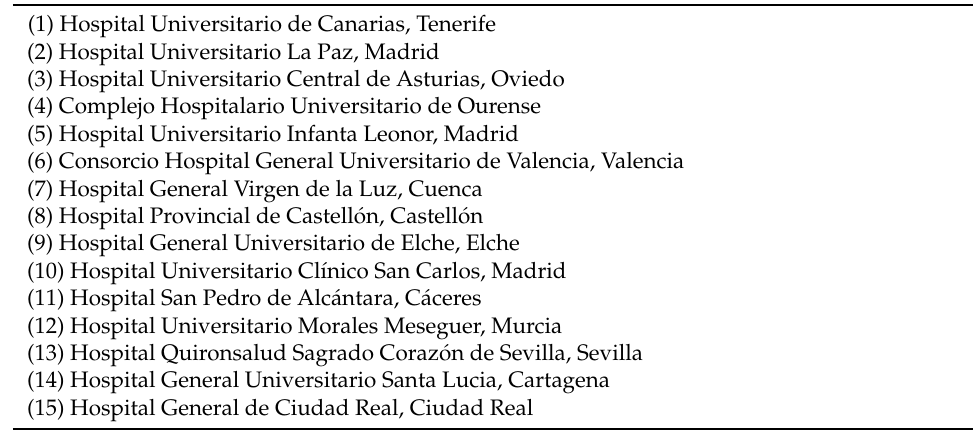
Table A1. List of 15 centers participants in the